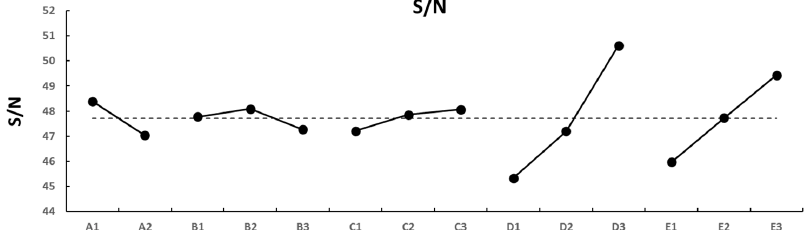
Figure 3. The fish-bone plot of the simplified S/N (cf. Equation (7)). The predominant factors become (D) the amplitude gain or (E) imaging compression ratio, unlike (C) the frame rate dominance, according to Equation (6).